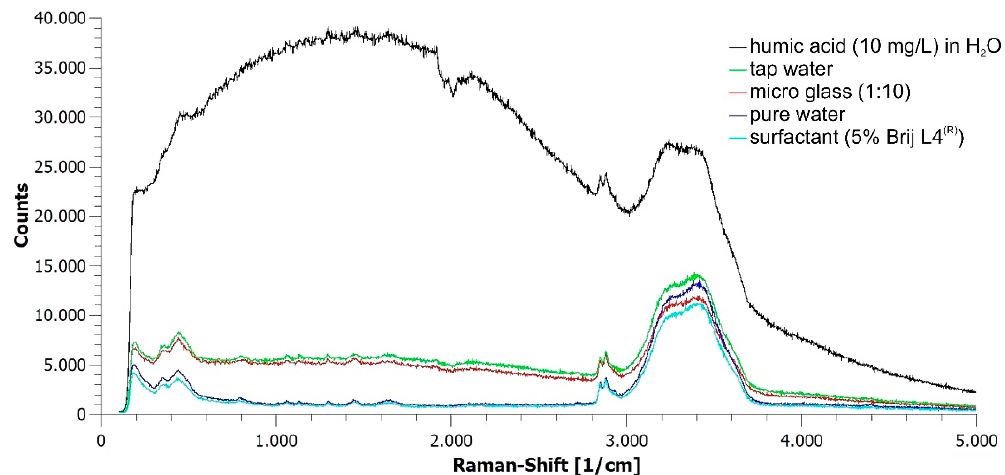
Figure 4. Raman spectra of individual polyethylene (PE) microparticles in water with various contaminants streaming with 1 L/h through the flow cell as recorded. Integration time T opt = T eff = 33 ms (16 ms in case of humic acid contamination; beam width within the flow cell: 1 mm; laser power within the flow cell: 1.54 W/mm²).